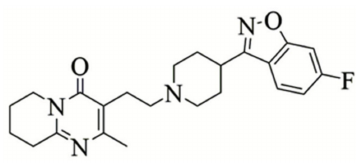
Figure 1. Chemical structure of